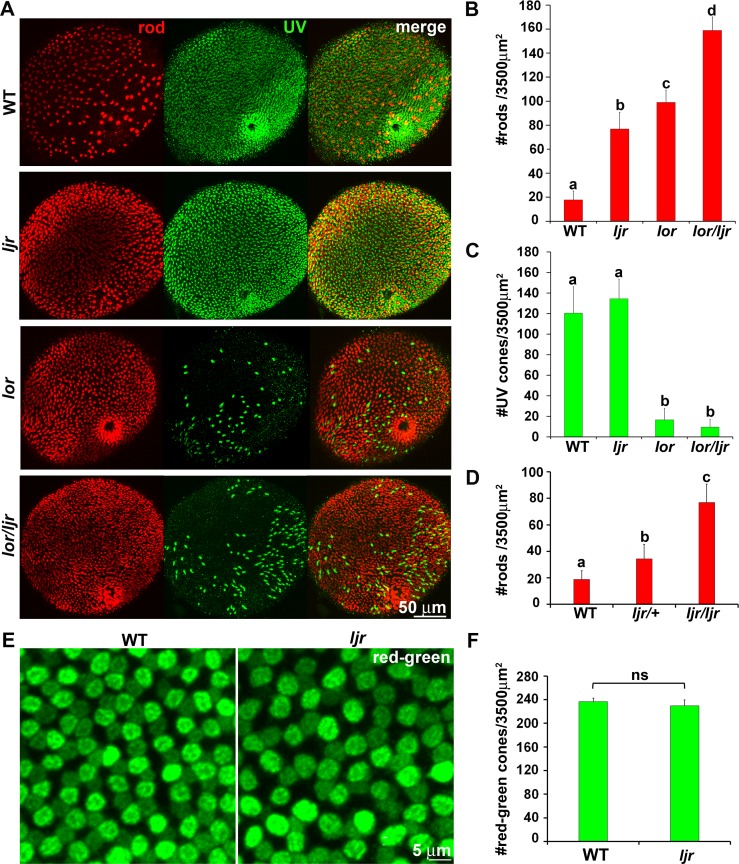
ljrp23ahub mutants display an increased number and uniform distribution of rod photoreceptors.(A) Confocal immunofluorescent images labeled for rods (red) and UV-sensitive cones (green) from WT, ljrp23ahub, lorp25bbtl and homozygous lorp25bbtl/ljrp23ahub retinas at 4 days-post-fertilization (dpf). WT larvae show asymmetric rod distribution in central and dorsal retina and a uniform distribution of UV-sensitive cones across the entire retina. ljrp23ahub and lorp25bbtl mutants demonstrate an increased number and uniform arrangement of rods but fewer UV-sensitive cones labeled in lorp25bbtl. Double-mutant retinas display higher rod labeling and few UV-sensitive cones. (B) Graph showing the average number of rods per unit area dorsal to the optic nerve (WT, n = 5; ljrp23ahub, n = 5; lorp25bbtl, n = 5; ljrp23ahub/lorp25bbtl, n = 5). Significantly-different means by one-way ANOVA with Tukey’s post-hoc test, b vs c, p<0.05, all other comparisons p<0.0001. (C) Graph showing the average number of UV-sensitive cones per unit area from samples used in 1B, a vs b, p<0.0001. (D) Graph showing the average number of rods per unit area (WT, n = 5; ljrp23ahub/+, n = 6; ljrp23ahub, n = 5); a vs b, p<0.05, all other comparisons p<0.0001. (E) Flat mount views of confocal immunofluorescent images labeled for red-sensitive (brighter signal) and green -sensitive (dimmer signal) cones from WT and ljrp23ahub retinas at 4 dpf. ljrp23ahub mutants maintain the alternating arrangement of red- and green-sensitive cones. (F) Graph showing the average number of red- and green-sensitive cones per unit area (WT, n = 6; ljrp23ahub, n = 6). No significant differences are observed, Student’s t test, p>0.05. Error bars represent SD.